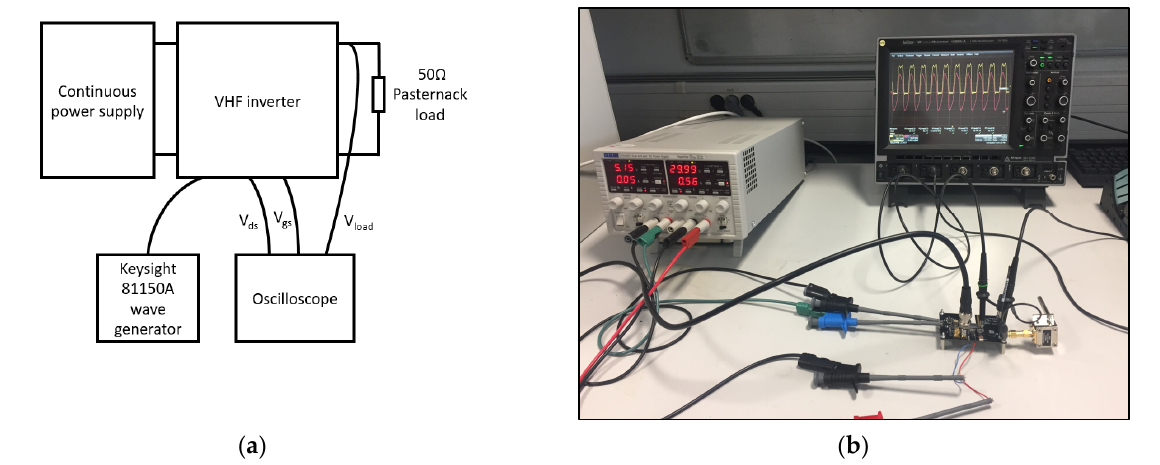
Figure 8. Diagram of the test bench ( a ), and L − Piezo inverter in operation ( b ).